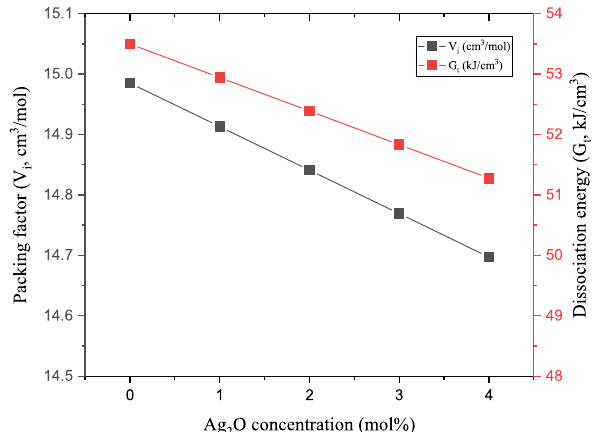
Figure 8. The variation of glasses’ packing factor and dissociation energy of the fabricated glasses versus the doped Ag 2 O ratio.